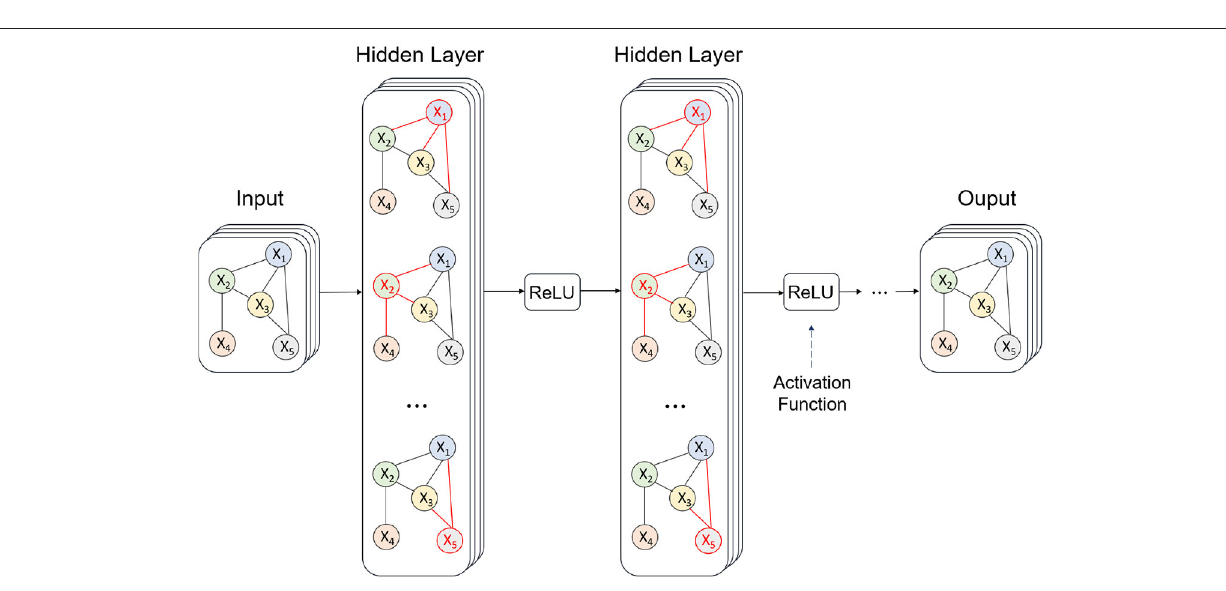
structure. It is a deep learning method for graph structured